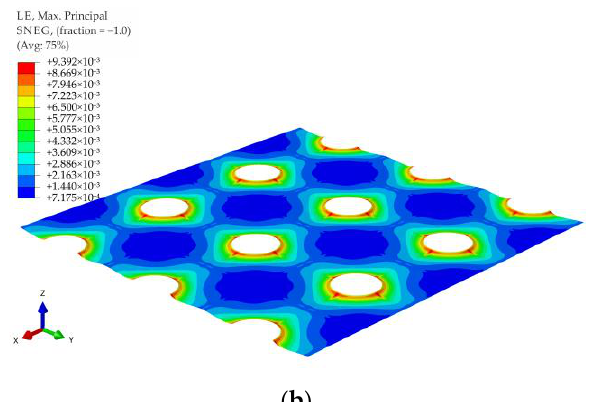
Figure 32. Deformation and maximum principal strain in reinforcement for inverse pyramid shape load distribution, variant B1: ( a ) k = 0 kN/m 3 ; ( b ) k = 500 kN/m 3 .